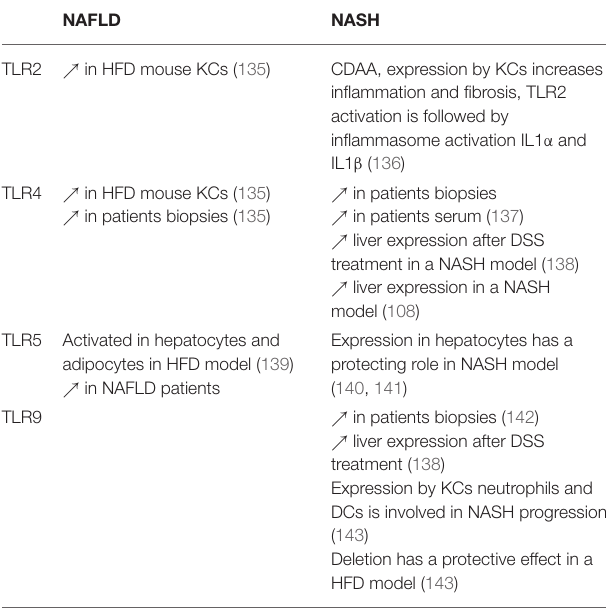
TABLE 2 | TLRs involvement in the progression of NAFLD and